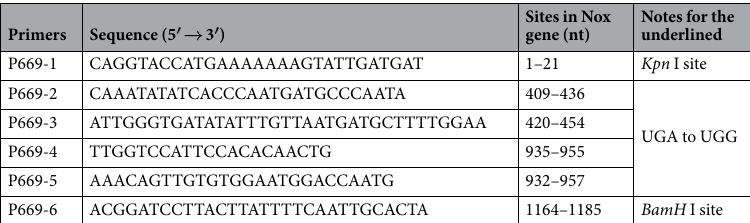
Primers Sequence (5 ′ → 3 ′ )